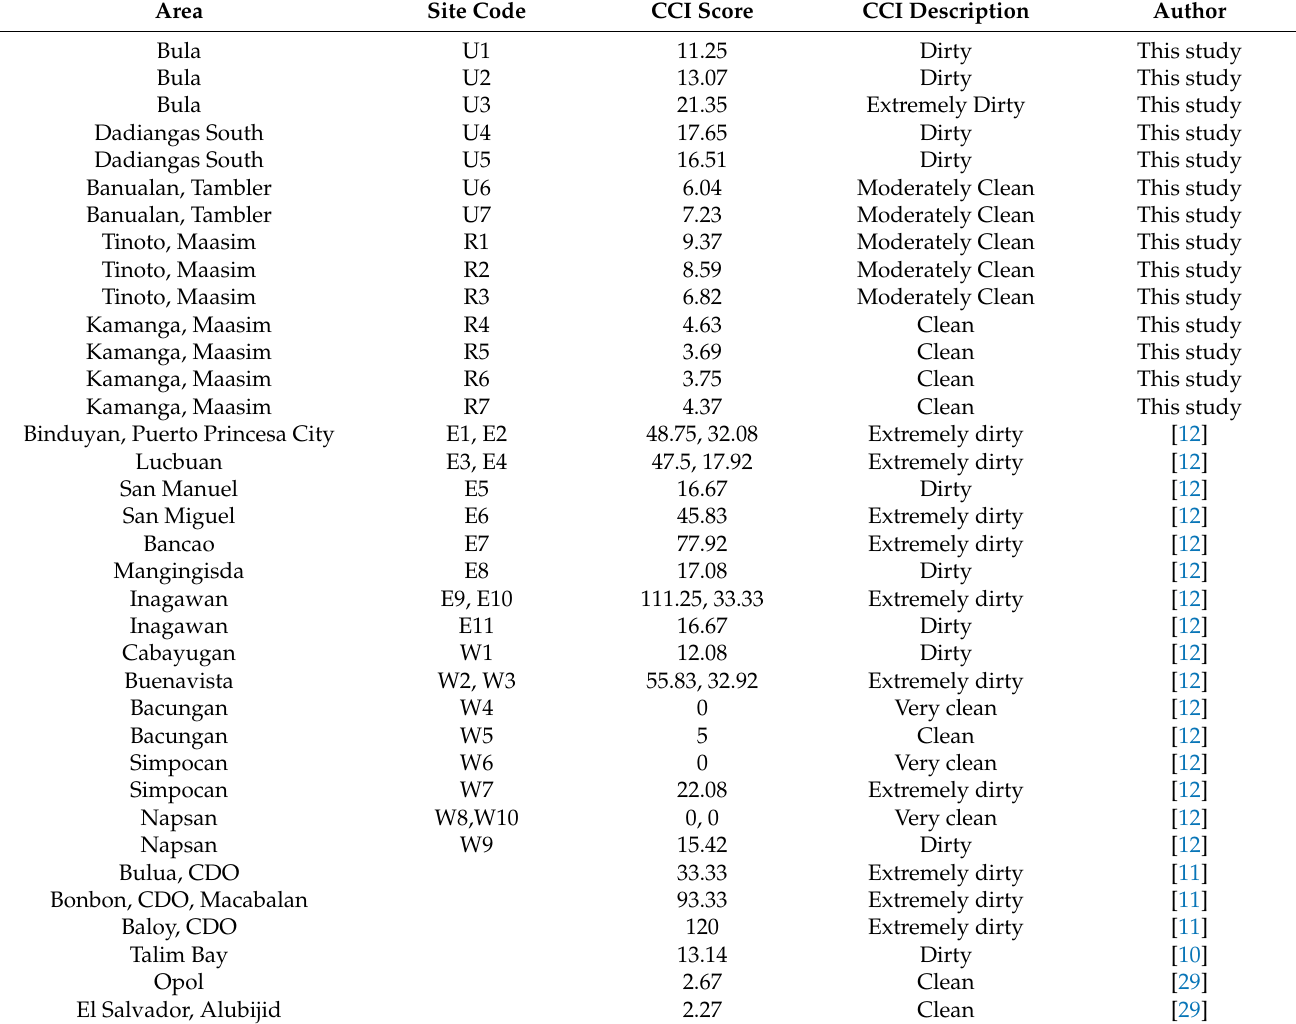
Table 3. Characteristics of the beaches in urban and rural areas in Sarangani Bay based on clean-coast index (CCI) compared to other studies in the